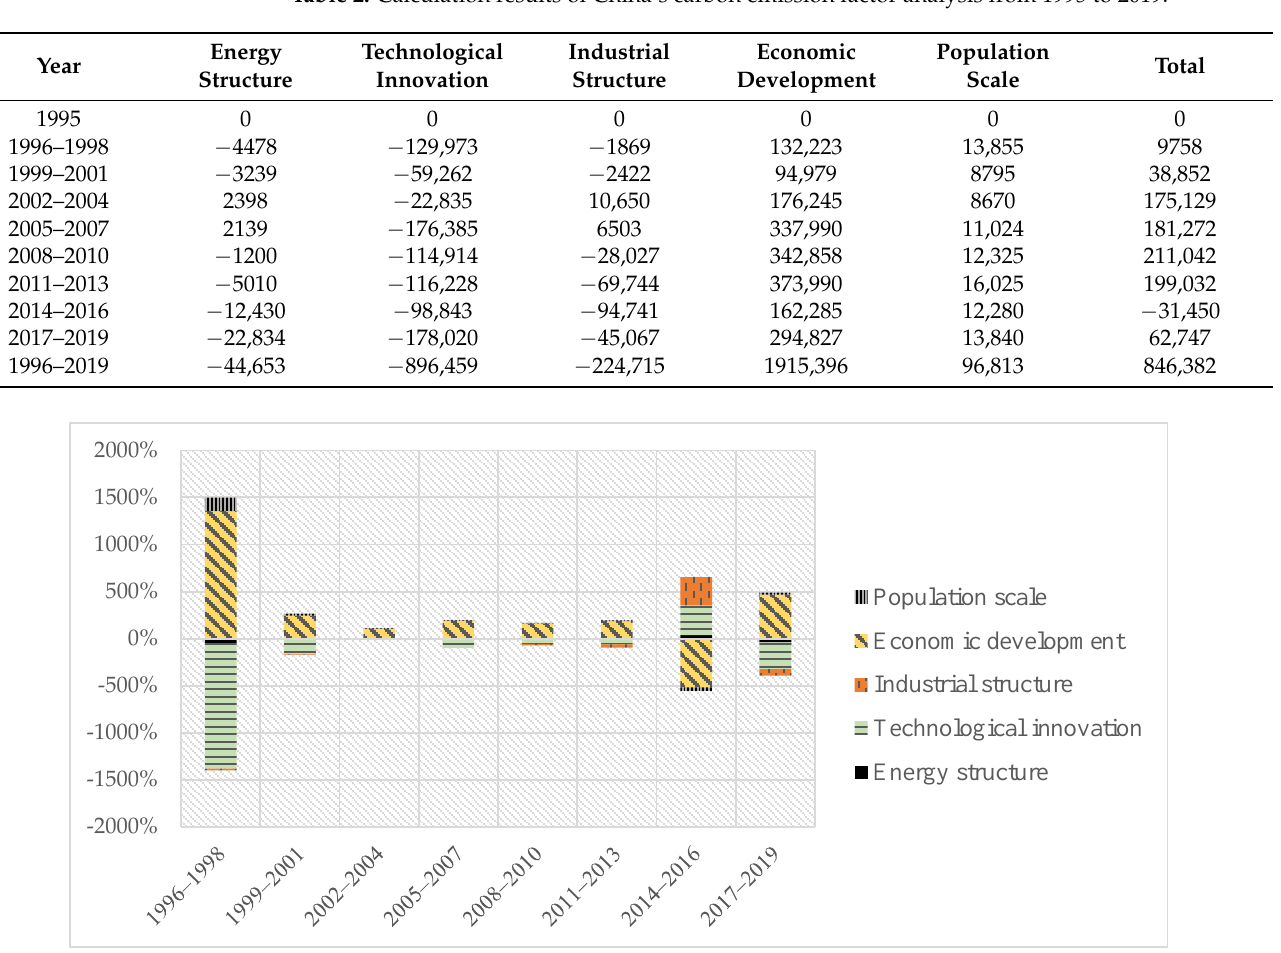
Figure 4. Contribution rate of influencing factors of China’s carbon emissions from 1996 to 2019.